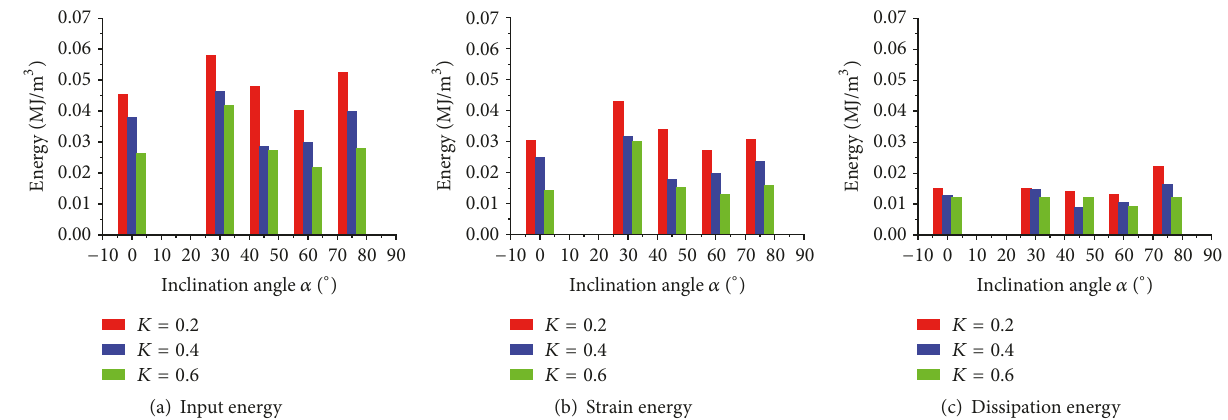
Figure 15: Energy of jointed specimens with different 𝑘 in laboratory